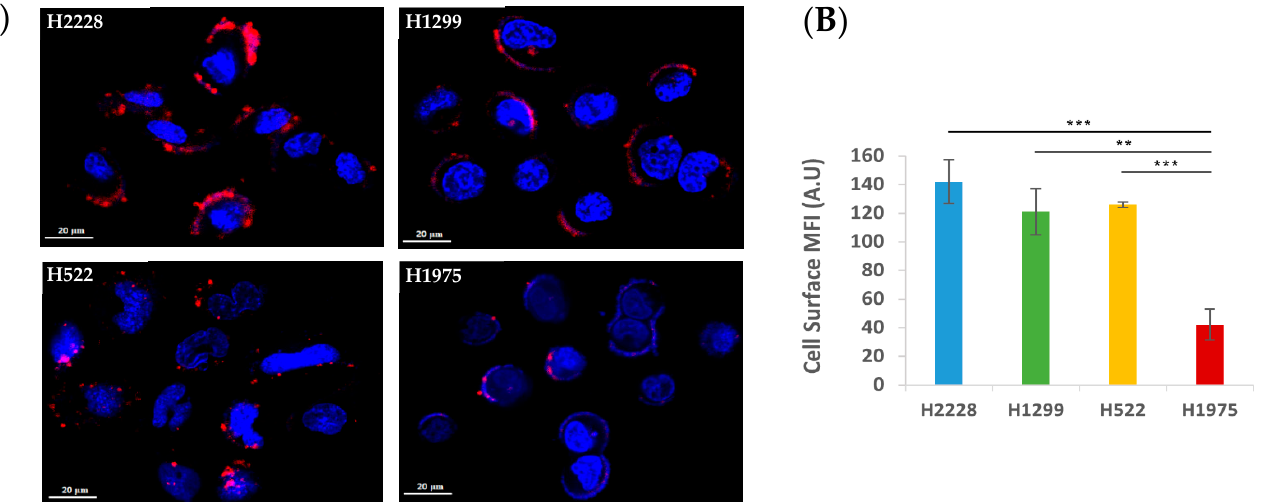
Figure 4. Cell surface binding of APT-NPs at 4 °C differs among NSCLC cell lines. ( A ) Confocal laser microscopy images of NSCLC cell lines incubated with PEG-PCL NPs decorated with S15 APTs. The studied tumor cell lines were H2228, H1299, H522 and H1975. Cells were incubated at 4 °C, for 50 min, in FBS-free medium, containing APT-NPs labeled with Cy7 (red). Nuclear DNA was labeled with Hoechst 33342 (2 µg/mL) (blue). ( B ) Mean fluorescence intensity (MFI) values of Cy7-labeled NPs bound to cells in panel A were determined using IMARIS software. Error bars represent SE. ** p < 0.01, *** p < 0.001, unpaired, two-tailed t